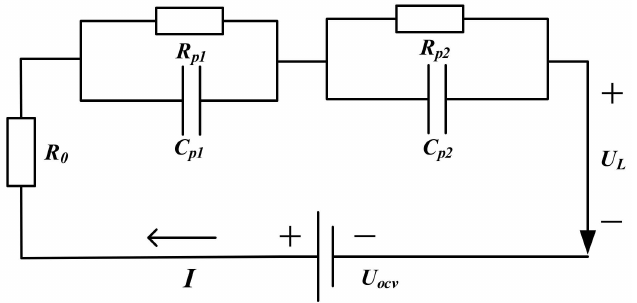
Figure 2. The structure of the DP